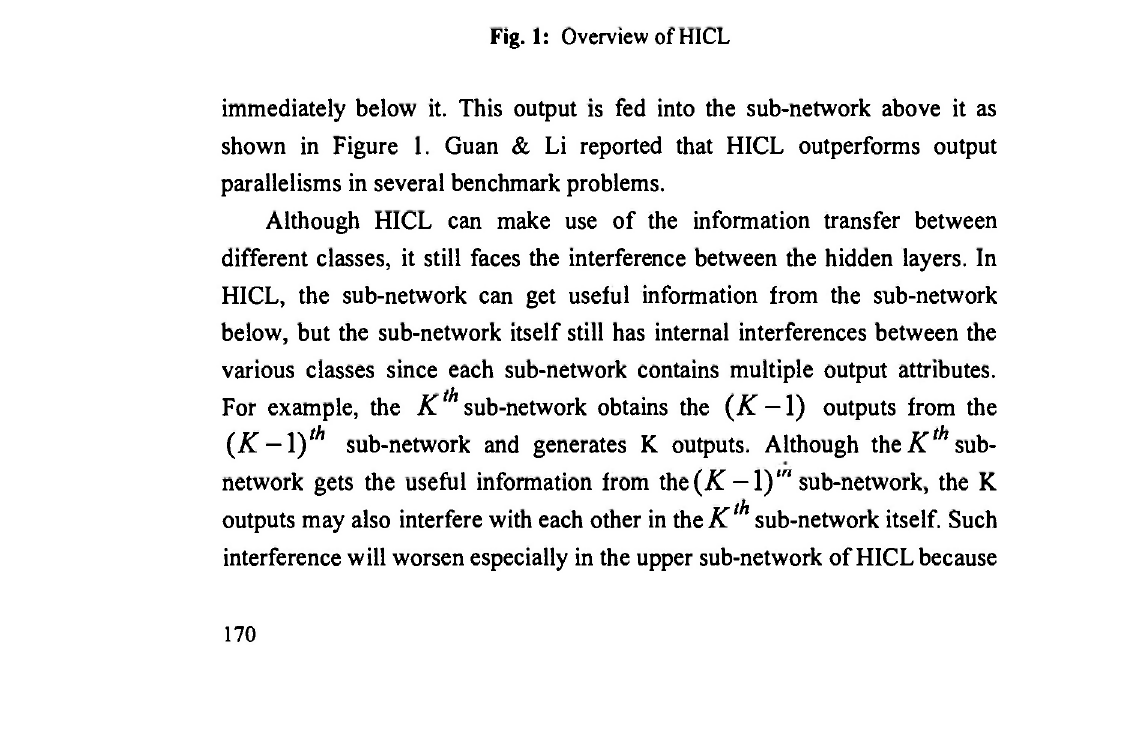
Fig. 1: Overview of